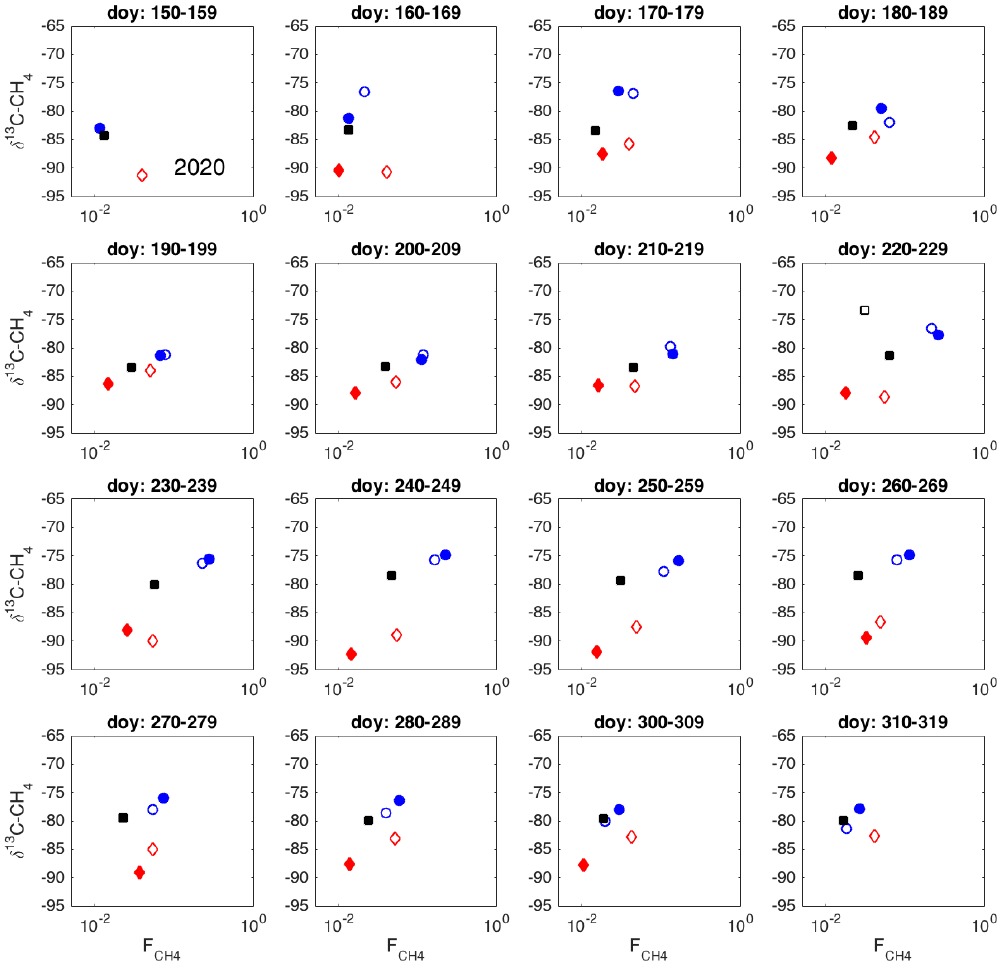
Figure A2. Spatial variation in δ 13 C-CH 4 against F CH , as 10d averages during 2020. Chamber 1: solid blue circle; chamber 2: open blue 4 circle; chamber 3: open black square; chamber 4: solid red diamond; chamber 5: open red square; chamber 6: solid black square.